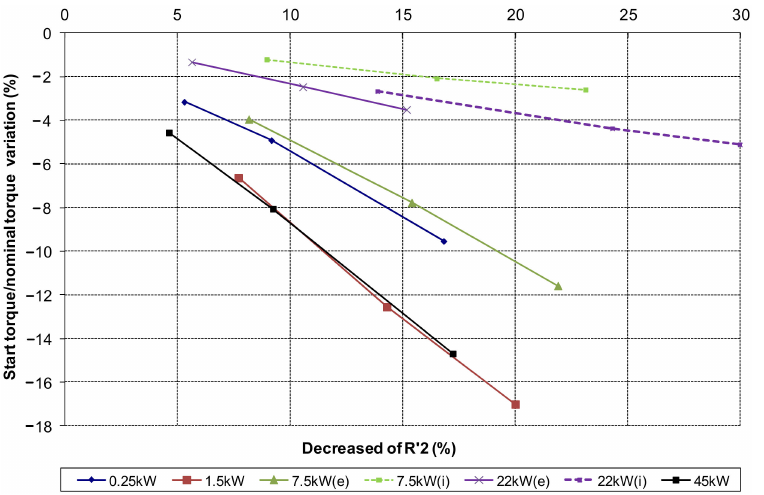
Figure 9. Start torque/nominal torque variation versus decreased of R (cid:48) 2 in all the motors (in the double cage motors, subscript e for external cage variation and subscript i for internal cage variation is